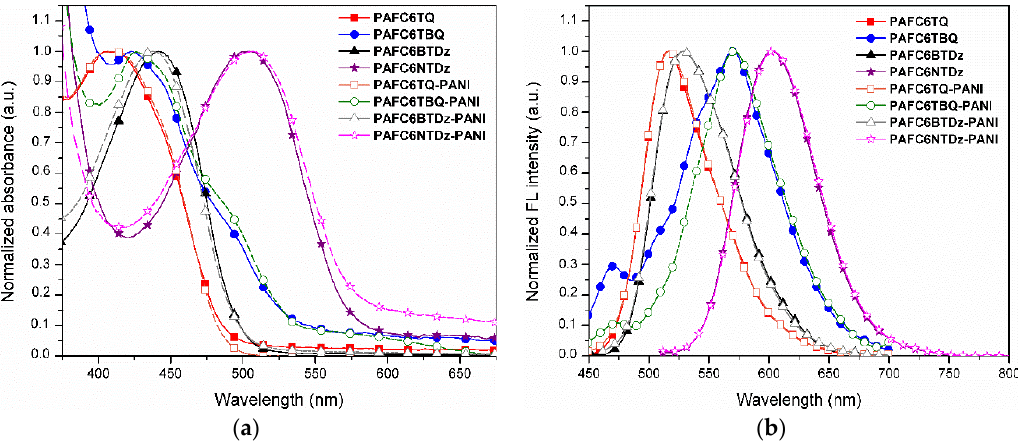
Figure 2. ( a ) Normalized UV ‐ Vis absorption; ( b ) and normalized fluorescence spectra of 1D ‐ and 2D ‐ copolymers as thin films.